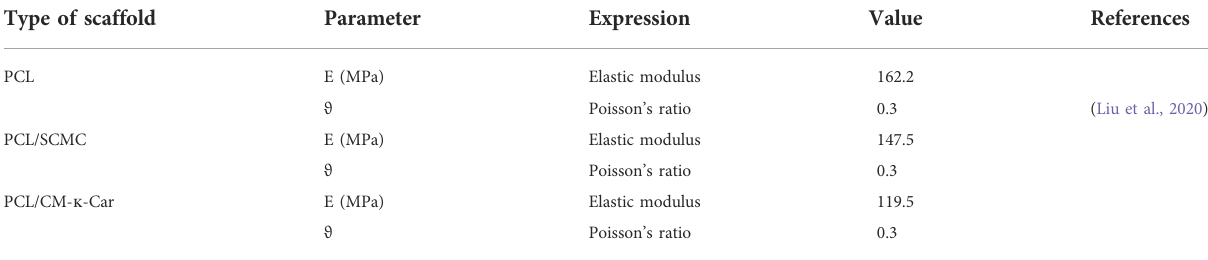
TABLE 1 Parameters and default values used in the FE